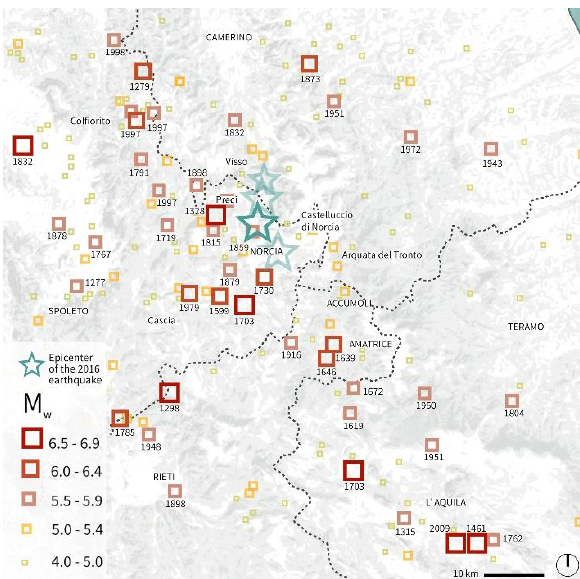
Figure 1. Historical earthquakes of the area. The blue stars indicate the epicenters of the 2016 seismic events.